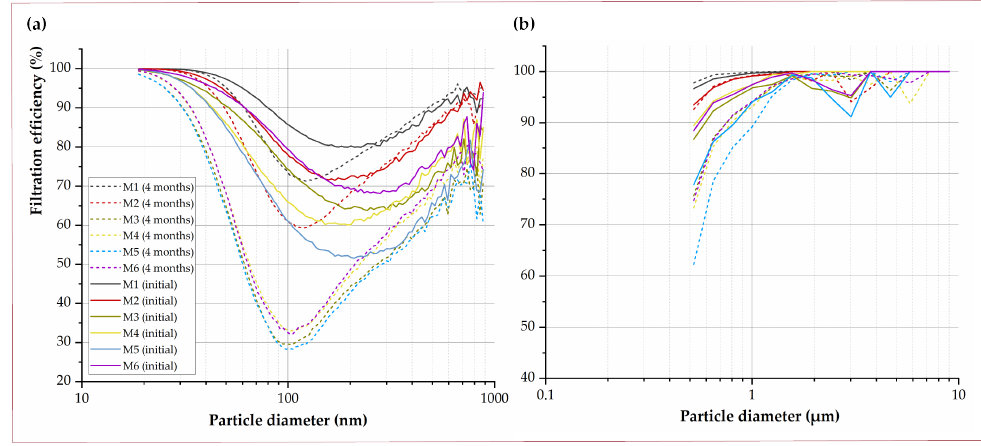
Figure 8. Loss of filtering efficiency after 2 ( a ) and 4 ( b ) months of samples stored at room temperature against 0.01–10.0 µ m. Table 2. Loss of filtering efficiency after 4 months of samples stored at room temperature (0.01–1.0 µ m particle size range).